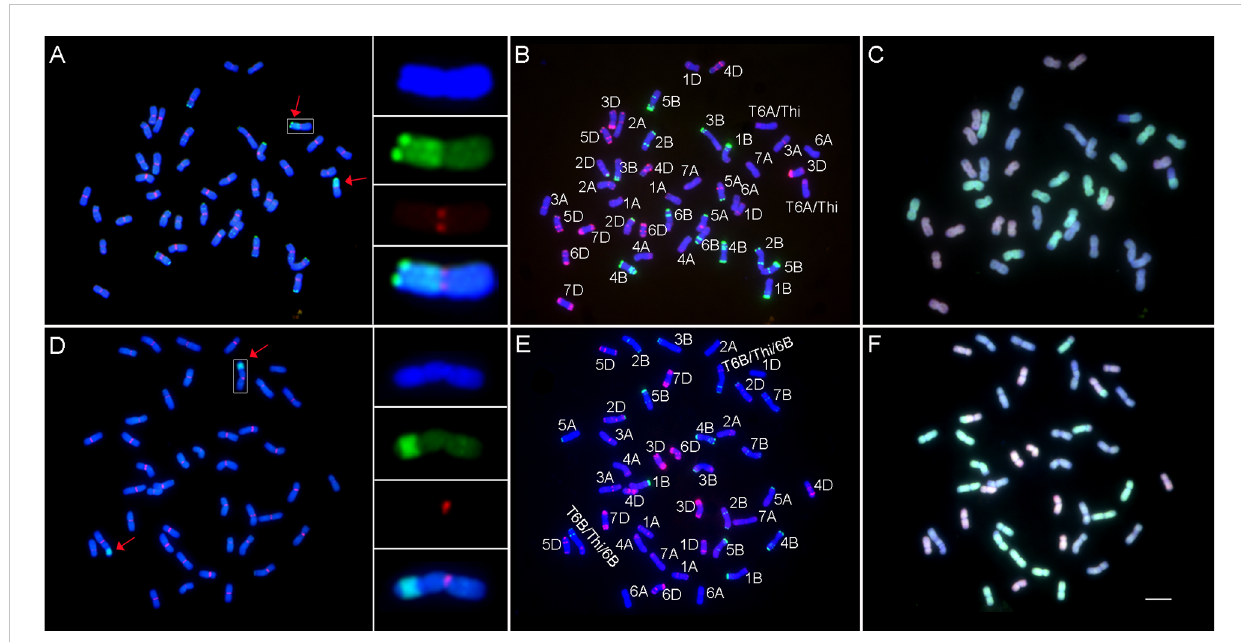
FIGURE 3 Cytological analysis on lines Zhongke 78 and Zhongke 15. (A – C) Cytological characterization of Zhongke 78. (D – F) Cytological characterization of Zhongke 15. GISH and FISH patterns of Zhongke 78 (A) and Zhongke 15 (D) . The genomic DNA of Th. intermedium (green) was used as probe for GISH and the wheat centromeric retrotransposon 6C6 (red) was used as probe for FISH. The genomic DNA of CS was used as a blocker. FISH patterns of Zhongke 78 (B) and Zhongke 15 (E) identi fi ed by Oligo-pTa535-1 (red) and Oligo-pSc119.2-1 (green). GISH patterns of Zhongke 78 (C) and Zhongke 15 (F) identi fi ed by the genomic DNA of Aegilops tauschii (DD) (red) and the genomic DNA of Triticum urartu (AA) (green). The genomic DNA of Ae. speltoides (SS) was used as a blocker. All chromosomes were counterstained with DAPI. Arrows indicated the translocated chromosomes. Scale bar = 10 m